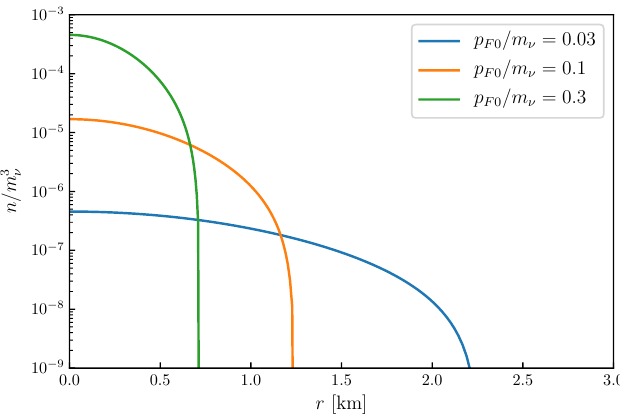
Figure 2 . Dependence of neutrino number density n ( r ) on distance from center for different values of central density p . We take y = 10 − 7 and m = 0 . 1 F 0 /m ν ν